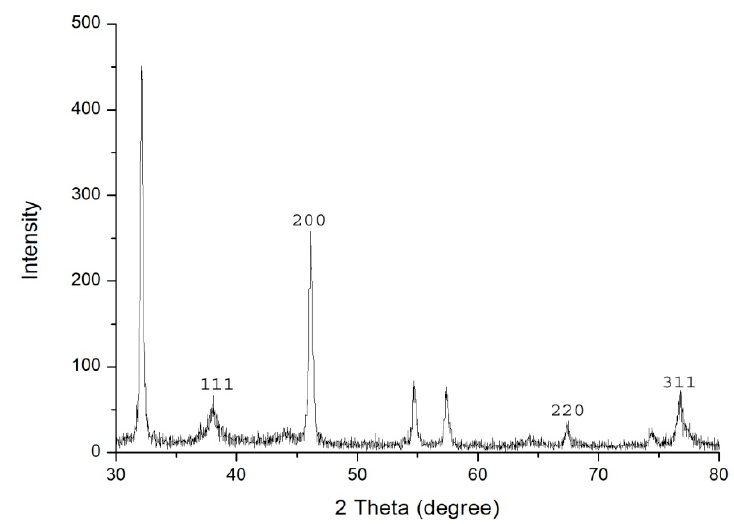
Figure 5. X-ray diffraction (XRD) pattern of biosynthesized AgNPs using culture supernatant of Citrobacter spp. MS5.